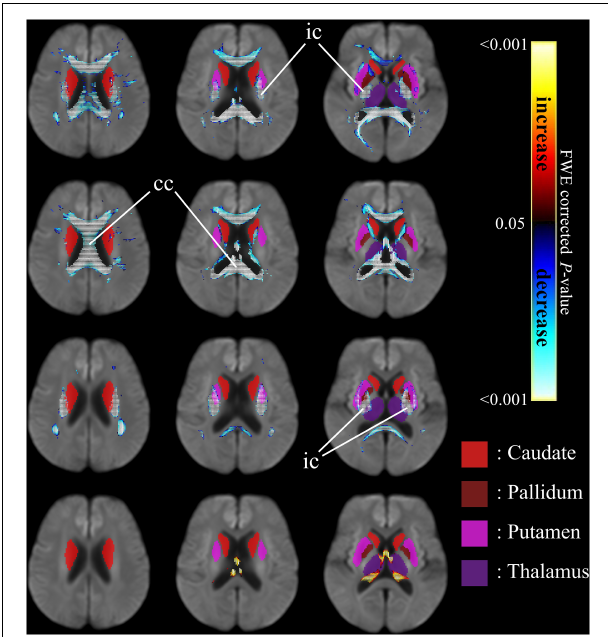
FIGURE 4 | Significant differences in tensor-derived indices from subcortical gray matter segmentation (shown in solid colors) and significant reductions in fixel-derived metrics in surrounding neighborhood regions, between patients with HD and healthy control participants. Areas of significant differences in FDC, FD, and FC displayed in the axial view. Significant fixels (family-wise error corrected p < 0.05) were illustrated and colored according to p -values. Cold colors denote reduction, whereas warm colors denote increase. Top row: FDC reductions in patients with HD compared to healthy controls; second row: FD reductions in patients with HD compared to healthy controls; third row: FC reductions in patients with HD compared to healthy controls; bottom row: areas of higher FC in patients with HD compared to healthy controls. ic, internal capsule; cc, corpus callosum.